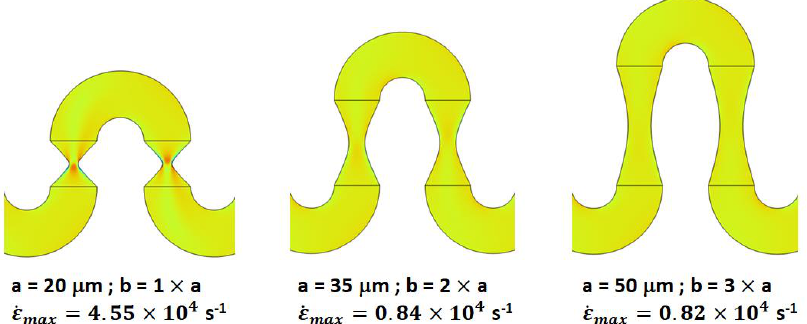
Figure 7. Stretch rate maps along the longitudinal cross-section of various constricted serpentine